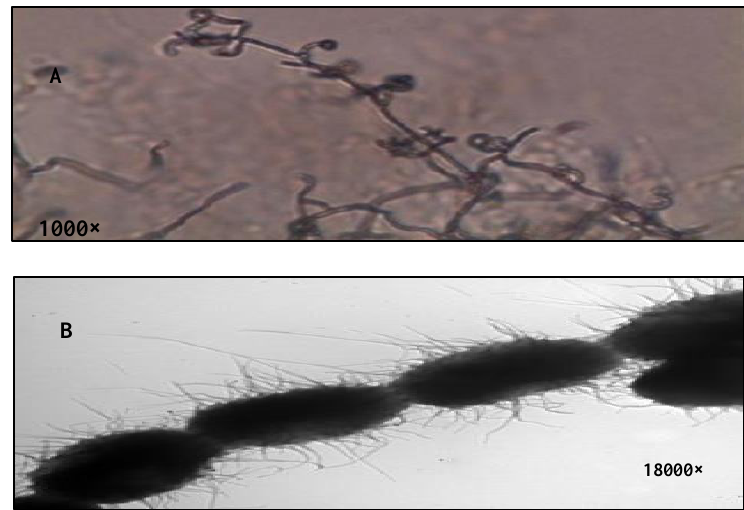
Figure 1. Characterization of Streptomyces atrovirens culture. ( A ): Spore chain morphology (1000×), ( B ): spore surface under electron microscope (18000×). Table 2. The selection of optimum conditions necessary for anti-dermatophytic substance production by S. atrovirens